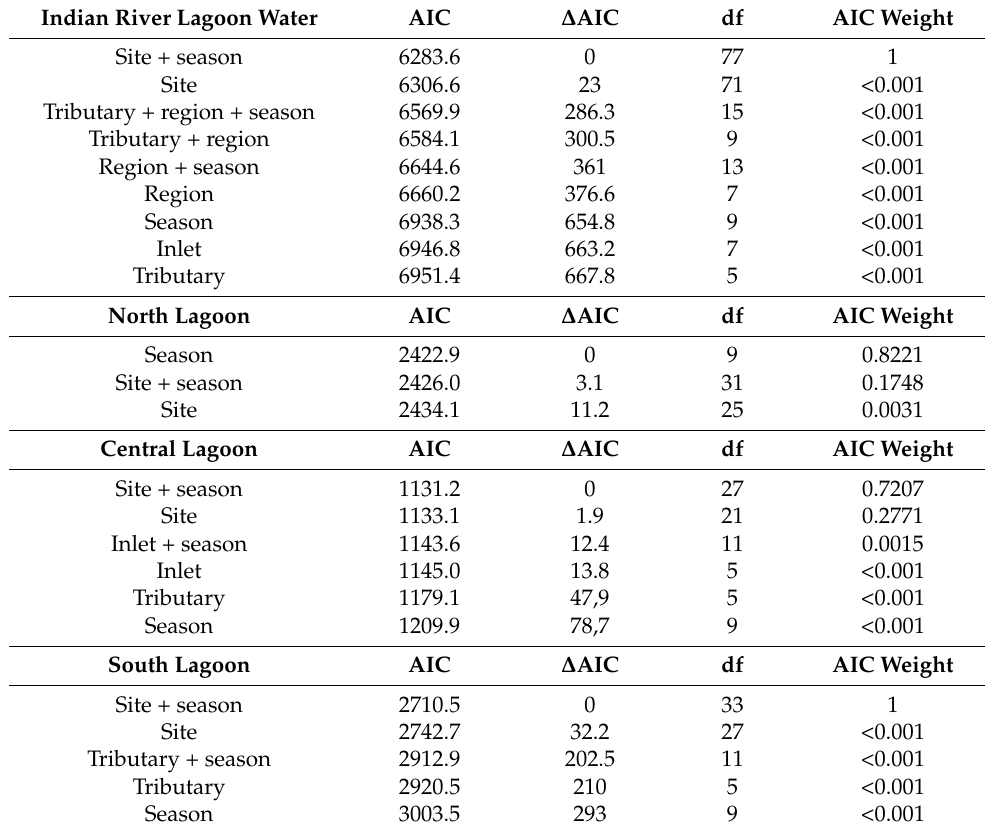
Table 2. Zero-inflated negative binomial GLM models of MP abundance in lagoon water overall and by region (north, central, south). Values reported are AIC, delta AIC, degrees of freedom, and AIC